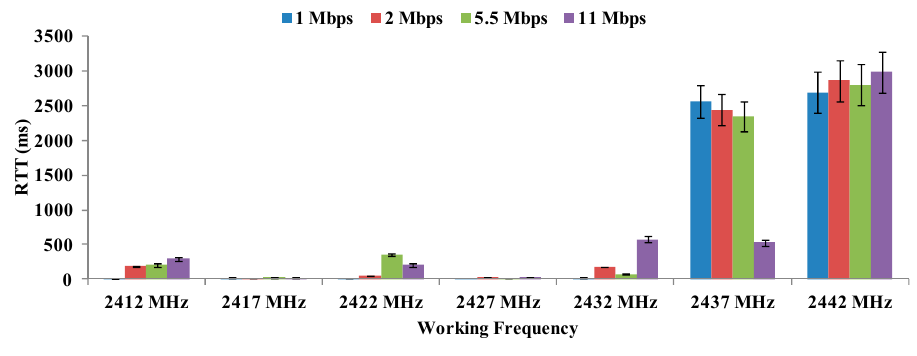
Figure 19. Values of RTT in ms for 26 °C.